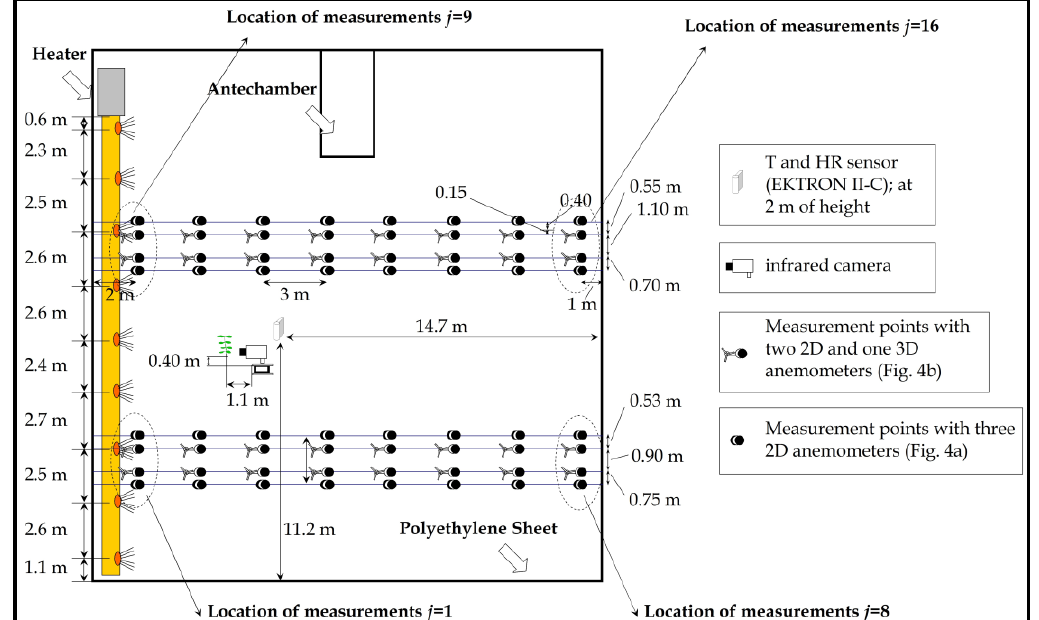
Figure 3. Measurement points with ultrasonic anemometers inside greenhouse